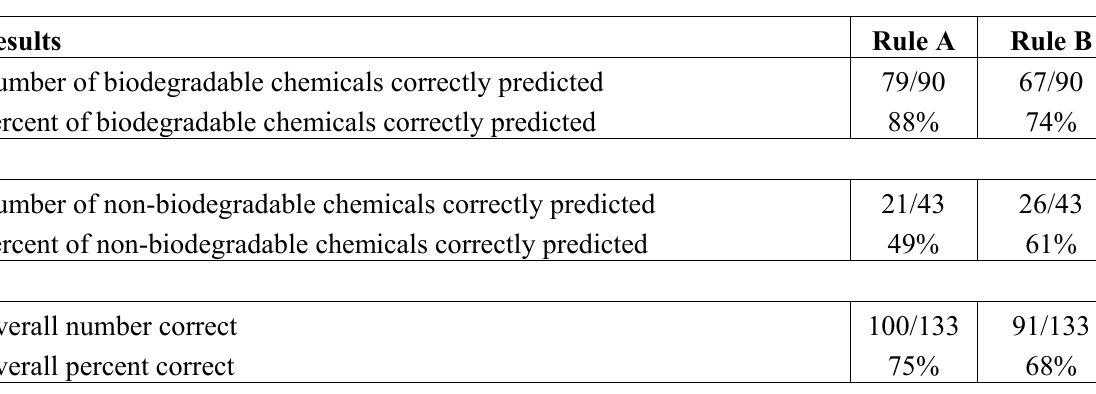
Table 8. Results of comparison of inductive machine learning Rules A and B against DIPPR BOD/ThOD data